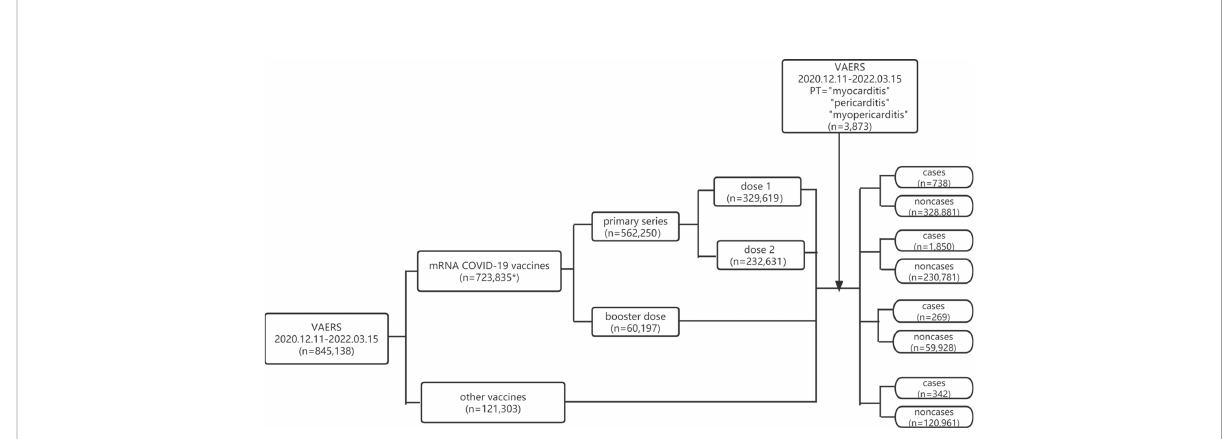
FIGURE 1 Flowchart of identifying cases and non-cases from VAERS database. VAERS, Vaccine Adverse Event Reporting System; mRNA, messenger RNA; COVID-19, coronavirus disease 2019; PT, preferred term. * including reports of primary series, booster dose and unspeci fi ed